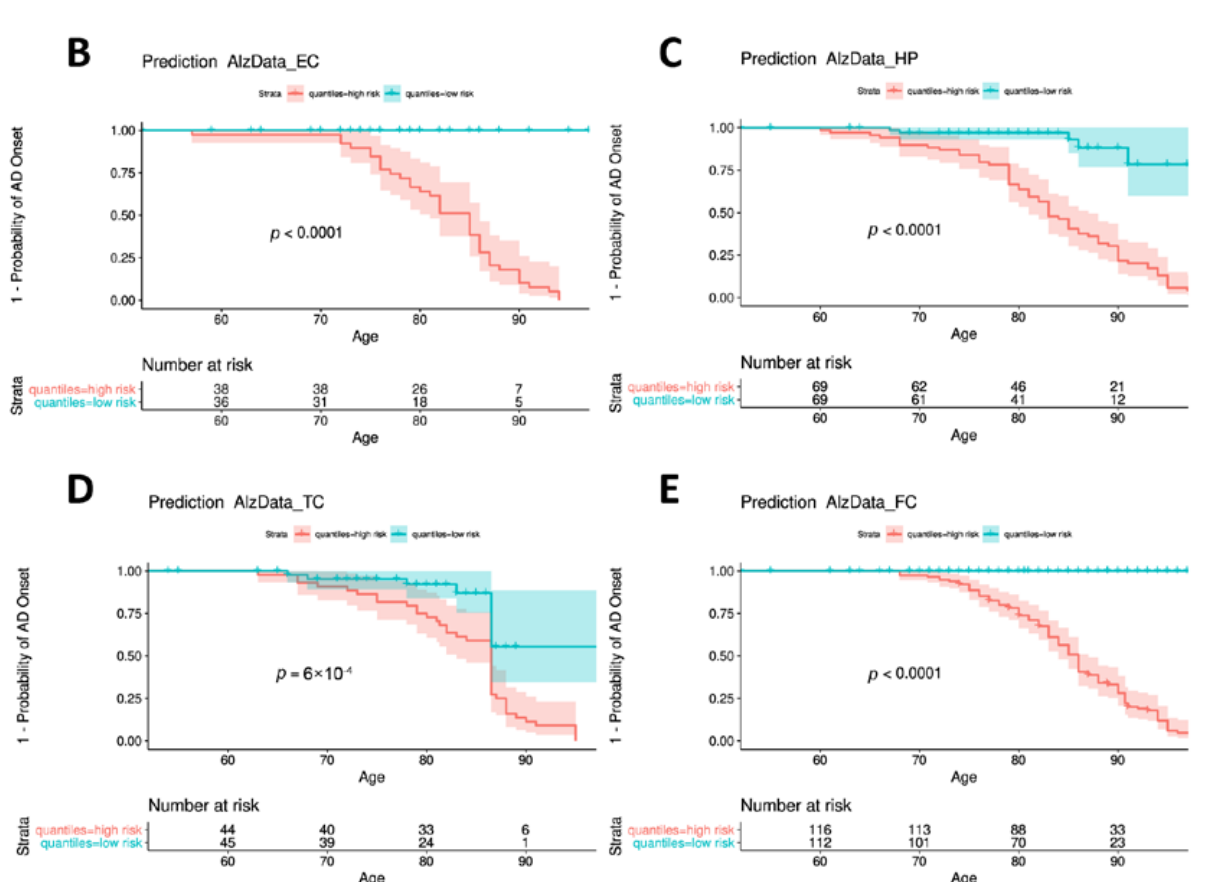
Figure 5. Construction and evaluation of AD predictive models based on AlzData. ( A ) Performance of predictive models based on AlzData. Due to the lack of expression values of approximately 2/3 hub genes, the FC region had the lowest AUC (0.610). For the other three regions, HP, EC, and TC, AUC values reached 0.757, 0.788, and 0.808, respectively. Kaplan–Meier survival curves showed that individuals in the high-risk group exhibited a significantly earlier age of AD onset in EC ( B ), HP ( C ), TC ( D ), and FC ( E ) (Log-rank test, p < 0.000 1 (excluding AlzData_TC p = 0.0006)). Abbrevi- ations: EC, Entorhinal Cortex; HP, Hippocampus; TC, Temporal Cortex; FC, Frontal Cortex.